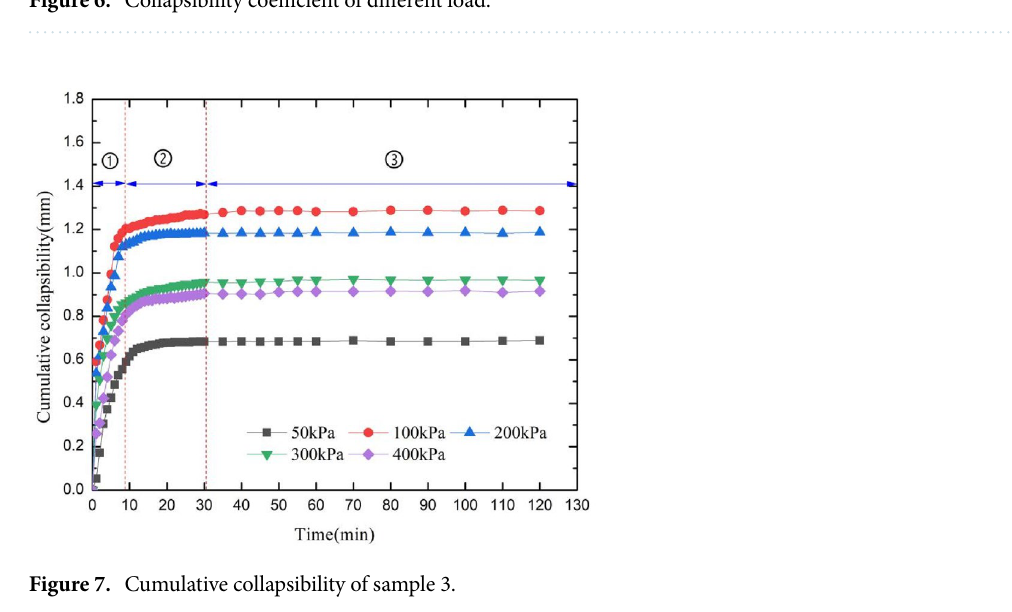
Figure 6. Collapsibility coefficient of different load.